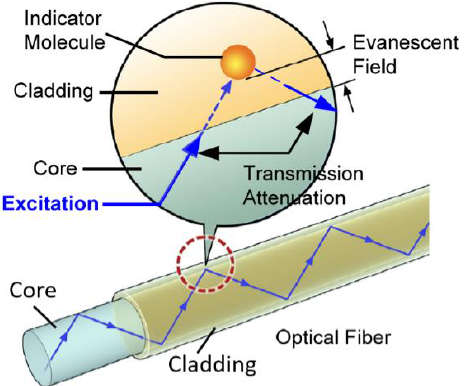
Figure 11. The figure shows the internal and external look of an evanescent field-based semicon- ductor Reprinted with permission from [112] Copyright 2014 Elsevier. Reprinted with permission from [112] Copyright 2014